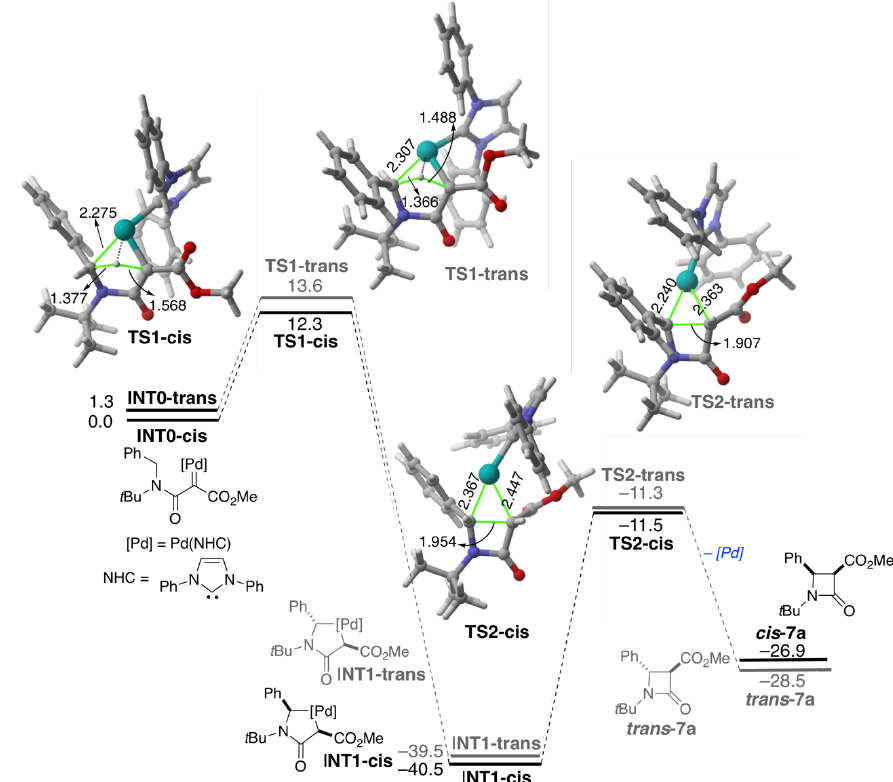
Figure 2. Computed reaction profile for the transformation of pallada(0)carbene INT0 into β -lactams cis -7a and trans -7a : Relative free energies and bond distances are given in kcal/mol and angstroms, respectively. All data have been computed at the PCM(dichloroethane)-B3LYP-D3/def2-TZVPP//PCM(dichloroethane)-B3LYP-D3/def2-SVP level.